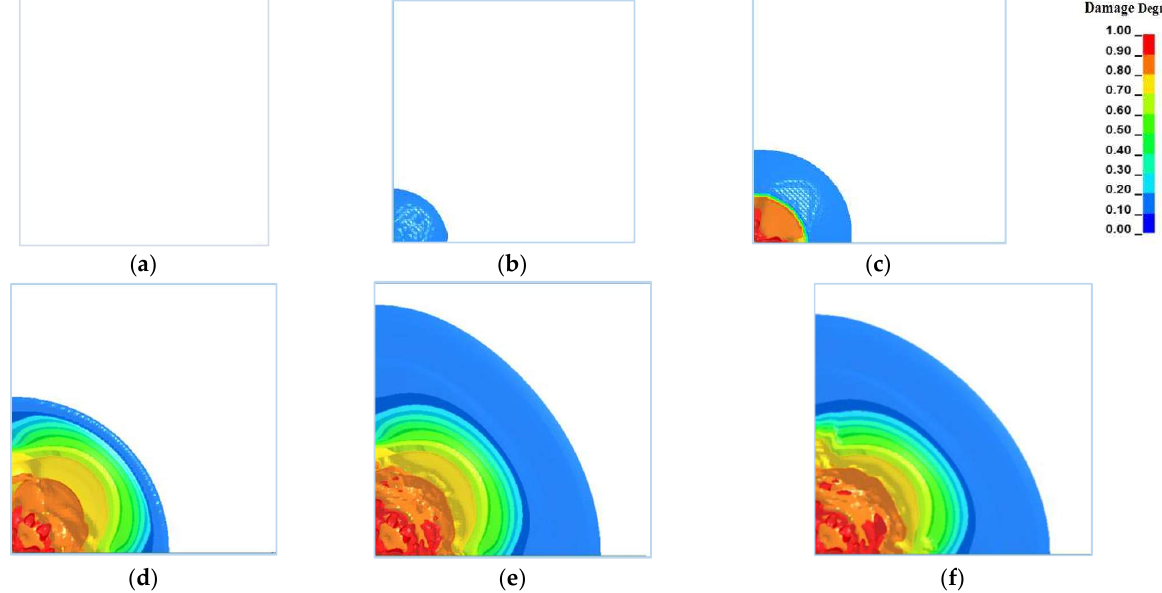
Figure 12. Blasting damage evolution law of groove-cavity in plane z = 0. ( a ) t = 0 µs. ( b ) t = 200 µs. ( c ) t = 400 µs. ( d ) t = 600 µs. ( e ) t = 800 µs. ( f ) t = 1000 µs.